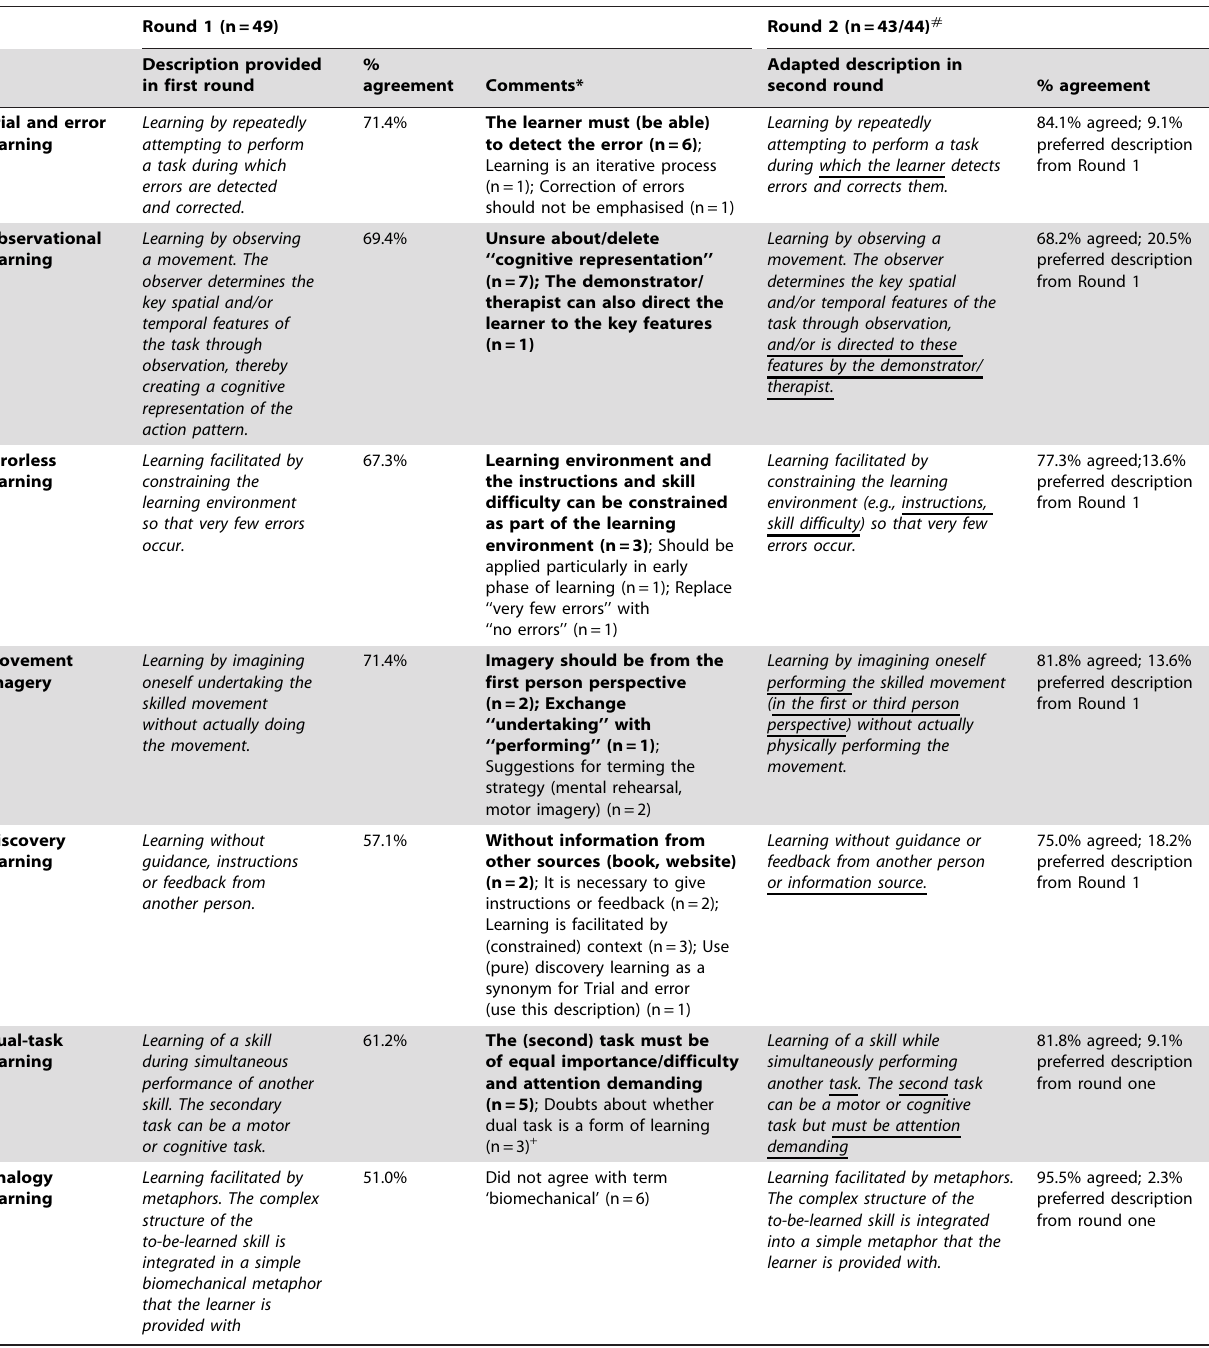
Table 6. Description of the best known strategies.